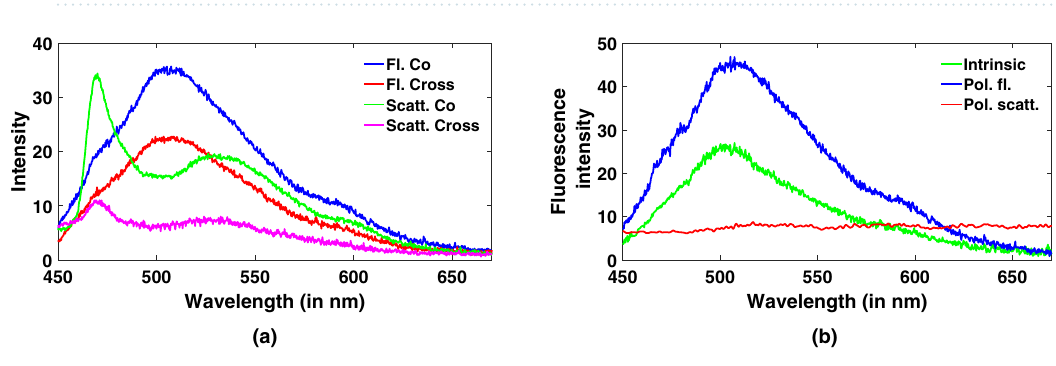
Figure 8. Typical plots of ( a ) co and cross polarized fluorescence and elastic scattering spectra and ( b ) polarized fluorescence, polarized scattering and intrinsic fluorescence